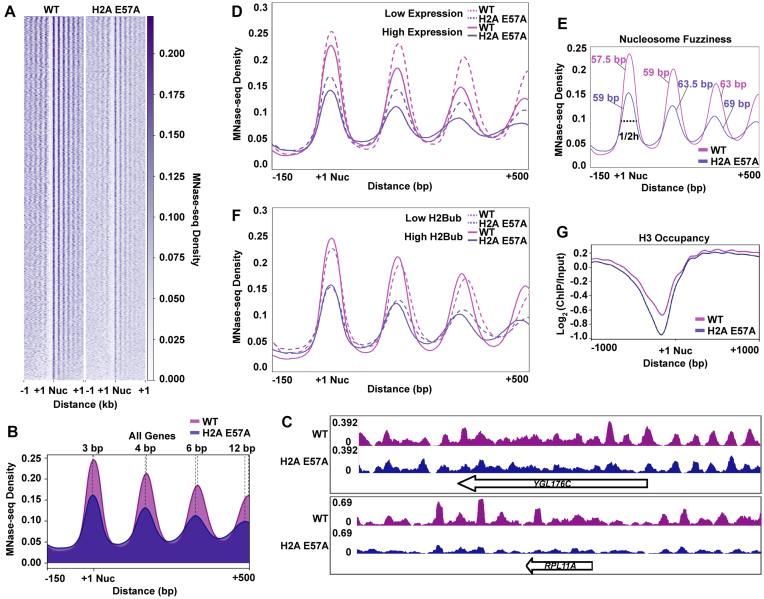
An intact nucleosome acidic patch is required for proper nucleosome occupancy and positioning. (A) Heatmaps of nucleosome positions as determined by MNase-seq analysis of strains expressing plasmid-encoded wild-type H2A or H2A-E57A as the only source of H2A. Sequences are aligned to the +1 nucleosome of ORFs (72). Heatmaps represent averages of two biological replicates. (B) Metaplot of nucleosome positions at all genes in the indicated strains. (C) Spike-in normalized MNase-seq reads at two individual genes. (D) Comparison of nucleosome positions in WT and H2A-E57A strains at lowly expressed and highly expressed genes (bottom 20% and top 20%) (85). (E) Comparison of peak widths at \documentclass[12pt]{minimal}
\usepackage{amsmath}
\usepackage{wasysym}
\usepackage{amsfonts}
\usepackage{amssymb}
\usepackage{amsbsy}
\usepackage{upgreek}
\usepackage{mathrsfs}
\setlength{\oddsidemargin}{-69pt}
\begin{document}
}{}$\frac{1}{2}$\end{document} peak height in WT and the H2A-E57A mutant. Greater peak width suggests poorer nucleosome positioning on average across genes. (F) Comparison of nucleosome positions at genes with high and low levels of H2Bub (bottom and top quintiles) (44). (G) Metaplot of H3 ChIP-seq data at all genes. Experiments were performed in biological duplicate.